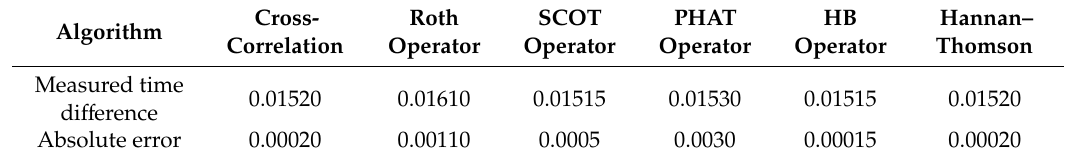
Table 3. Time-di ff erence measurement results based on the generalized correlation method (unit: